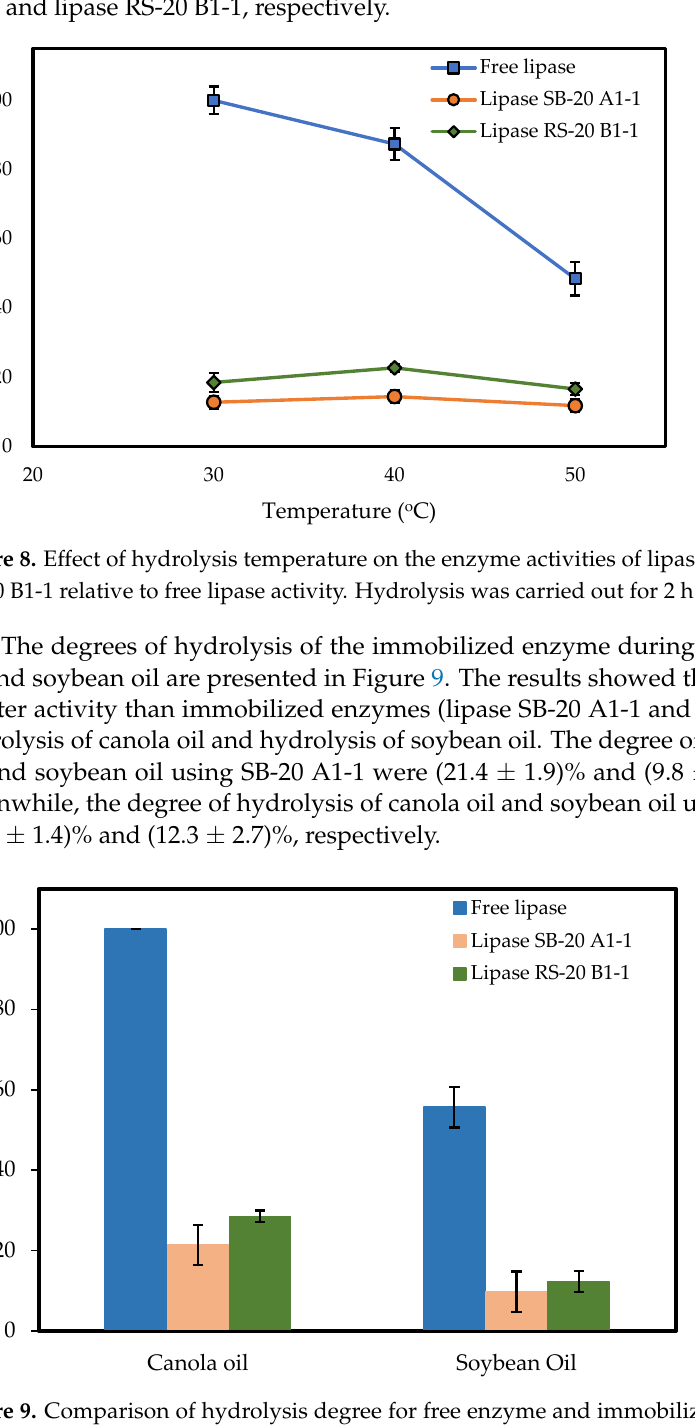
Figure 9. Comparison of hydrolysis degree for free enzyme and immobilized lipase on sugarcane bagasse (SB ‐ 20 A1 ‐ 1) and rice straw (RS ‐ 20 B1 ‐ 1). Hydrolysis was carried out at 40 °C for 6 h.